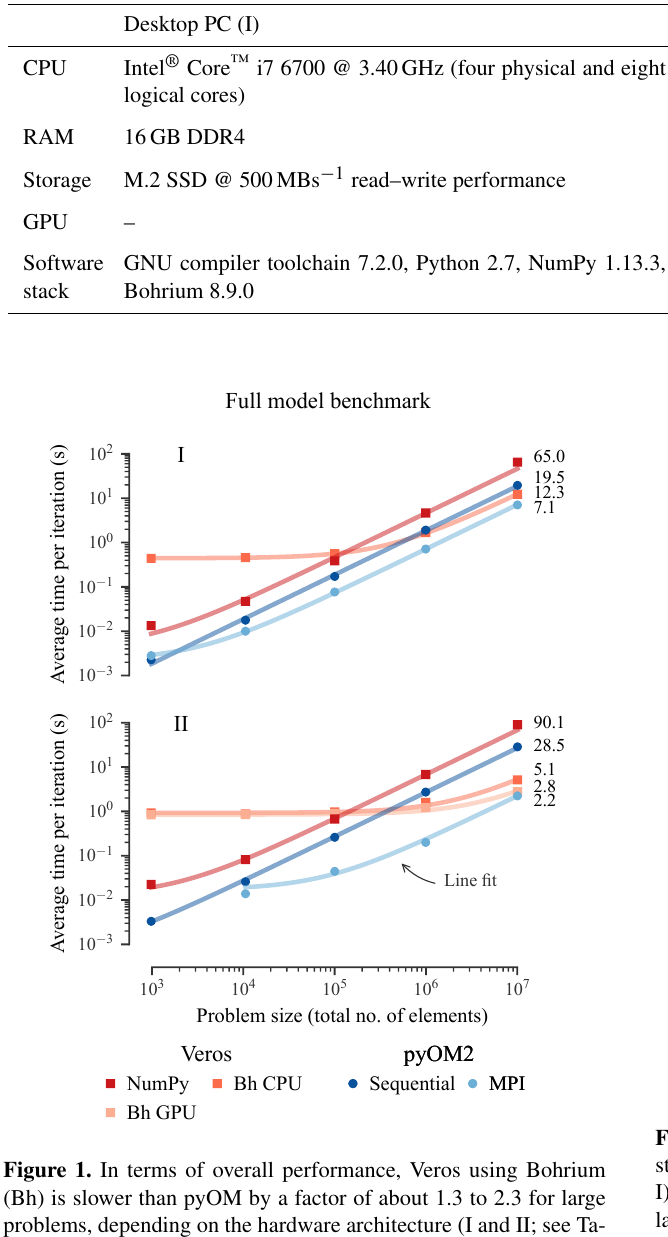
Table 1. Specifications of the two benchmark architectures.